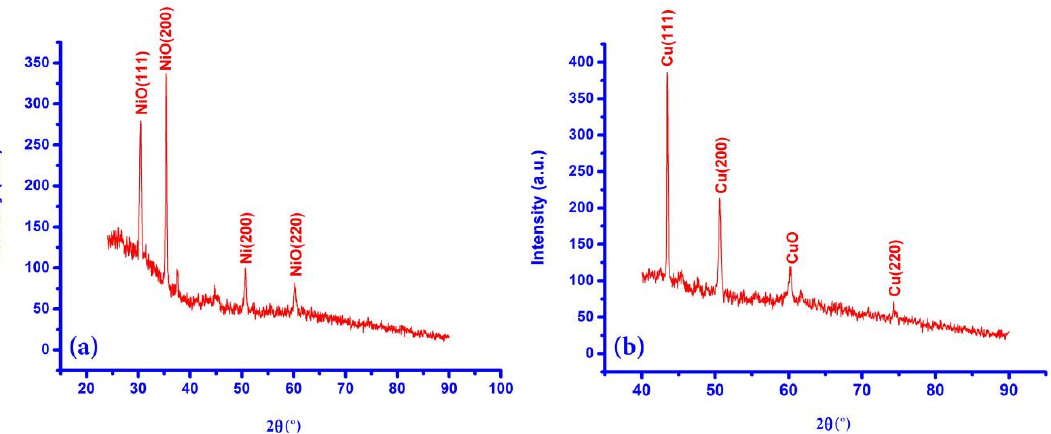
Figure 1. XRD pattern of NiO on PASP/NiO/FTO ( a ) and Cu/PTRP/FTO and Cu/PNR/FTO ( b ).